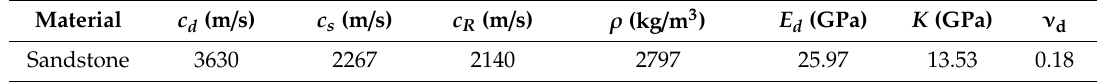
Table 1. Material parameters of YaMeng black